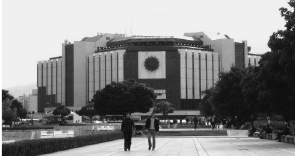
Figure 1 (left above): The National Palace of Culture in Sofia – the venue of the 12th European Conference on Clinical Hemorheology.